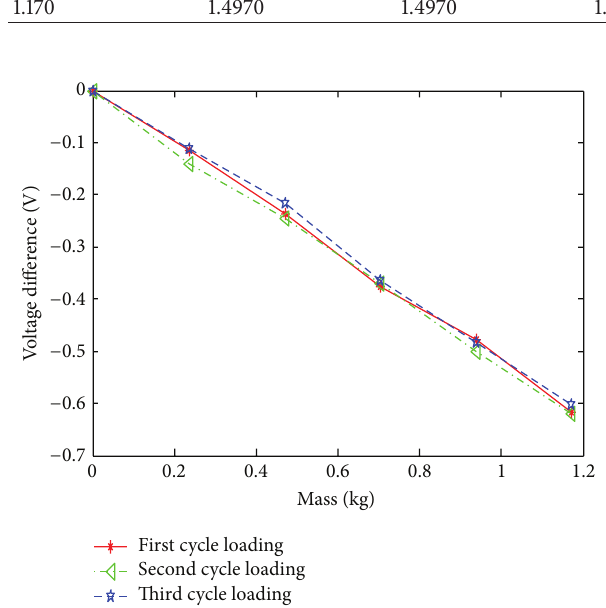
Figure 8: Three cycles unloading.